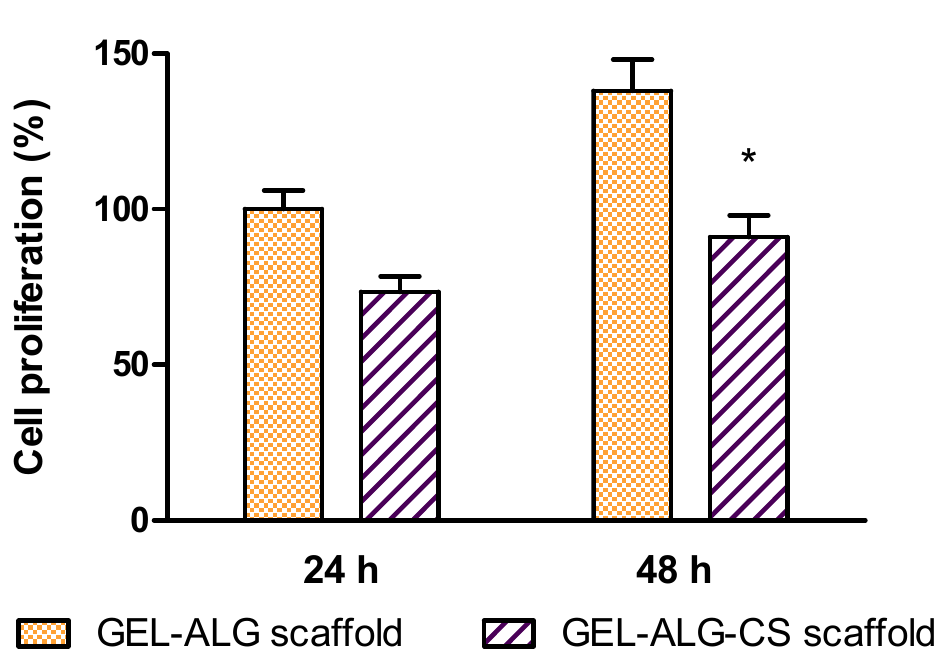
Figure 9. Viability of 3T3 fibroblasts evaluated by the MTT test at 24 h for GEL–ALG–CS scaffold. Viability rate in GEL–ALG scaffold was considered as 100%. Results are expressed as mean ± SD from triplicate experiments. * p < 0.05 .